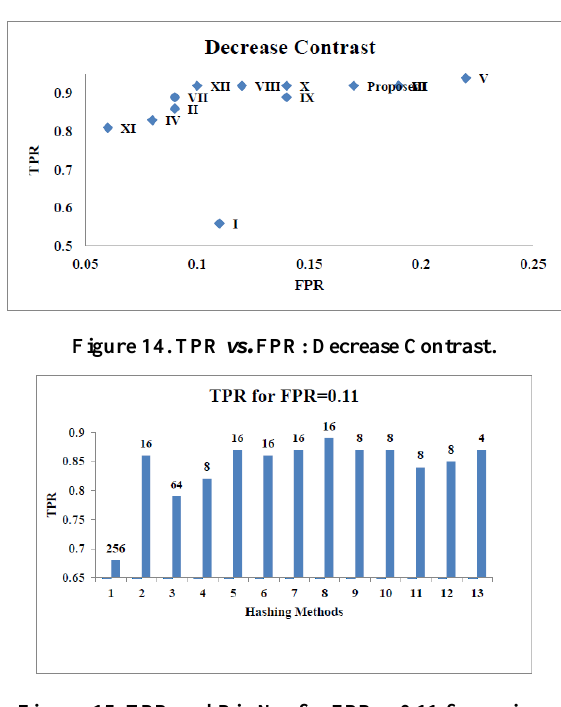
Figure. 15. TPR and Bin No. for FPR = 0.11 for various